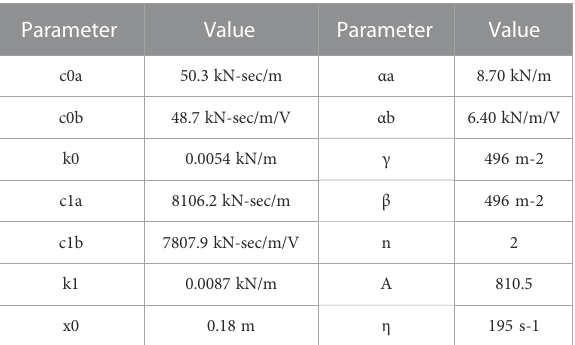
TABLE 1 Parameters of MR